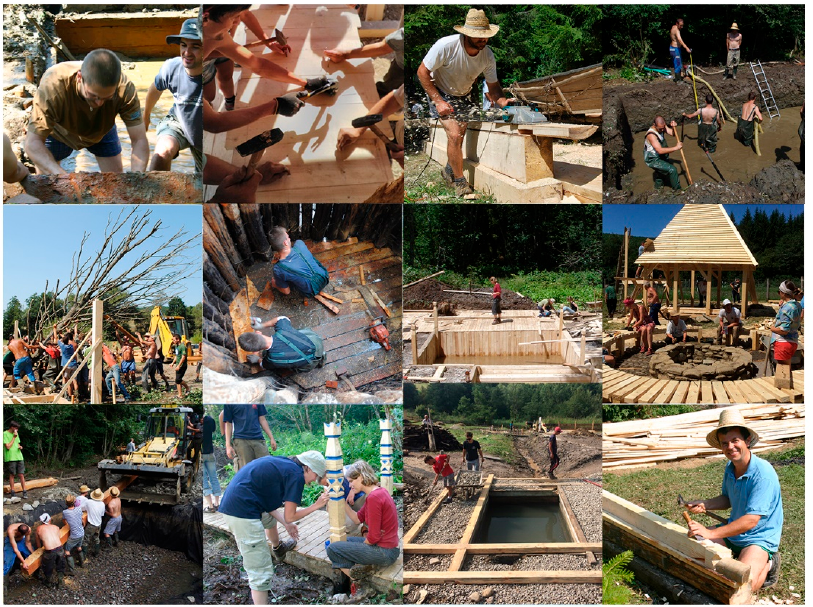
Figure 10. Instant photos of community work. Source: Albert Fekete, Gábor Kulich, Máté Sárospataki, Ars Topia Foundation.